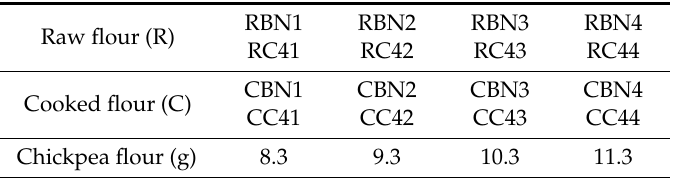
Table 1. Identification codes for custard